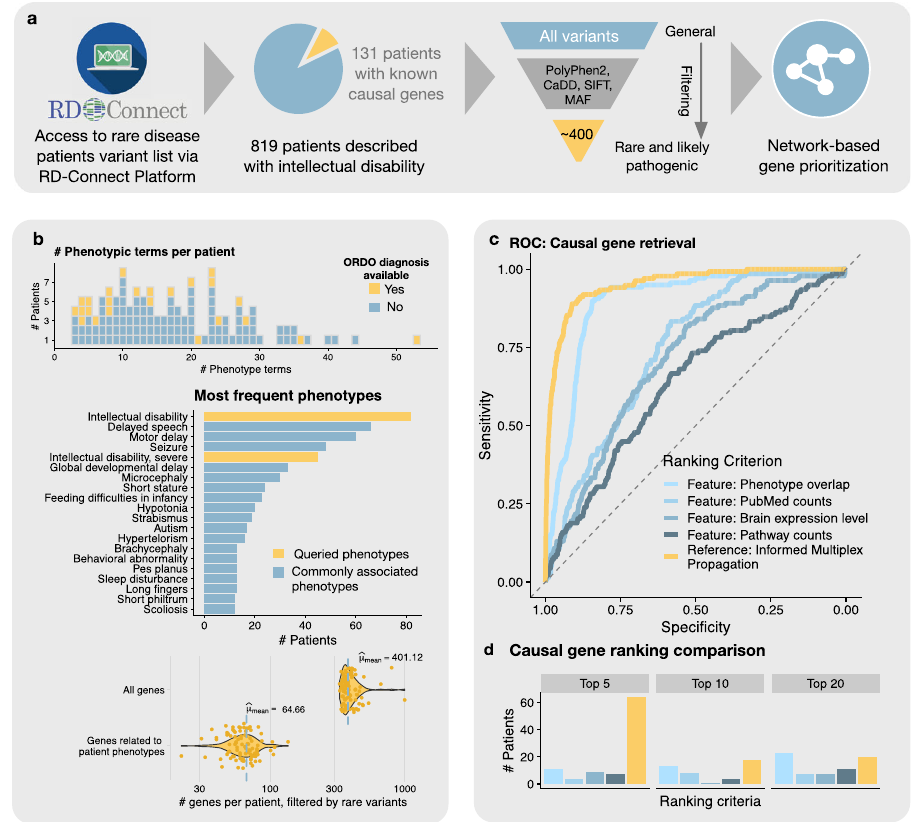
Fig. 6 Patient cohort and gene prioritization performance. a Data access and fi ltering: Querying for intellectual disability phenotypes resulted in 819 patients, 131 of which were solved cases with rare and pathogenic variants in an average of over 400 genes. b Basic characteristics of patient variants, associated phenotypes and diagnoses. c ROC curves for the performance of causal gene prioritization of our approach (yellow, AUROC = = 0.95) and various gene level based benchmarks (AUROC between 0.59 and 0.87). d Number of patients for which the true causal gene was prioritized among the top fi ve, 10, and 20 for all considered methods. The informed multiplex propagation placed the true causal gene among the top fi ve ranked genes for 64 out of 131 patients (48.9%). For the purely gene-based methods, the causal gene was among the top fi ve in only between 4 and 11 patients (3.1 –